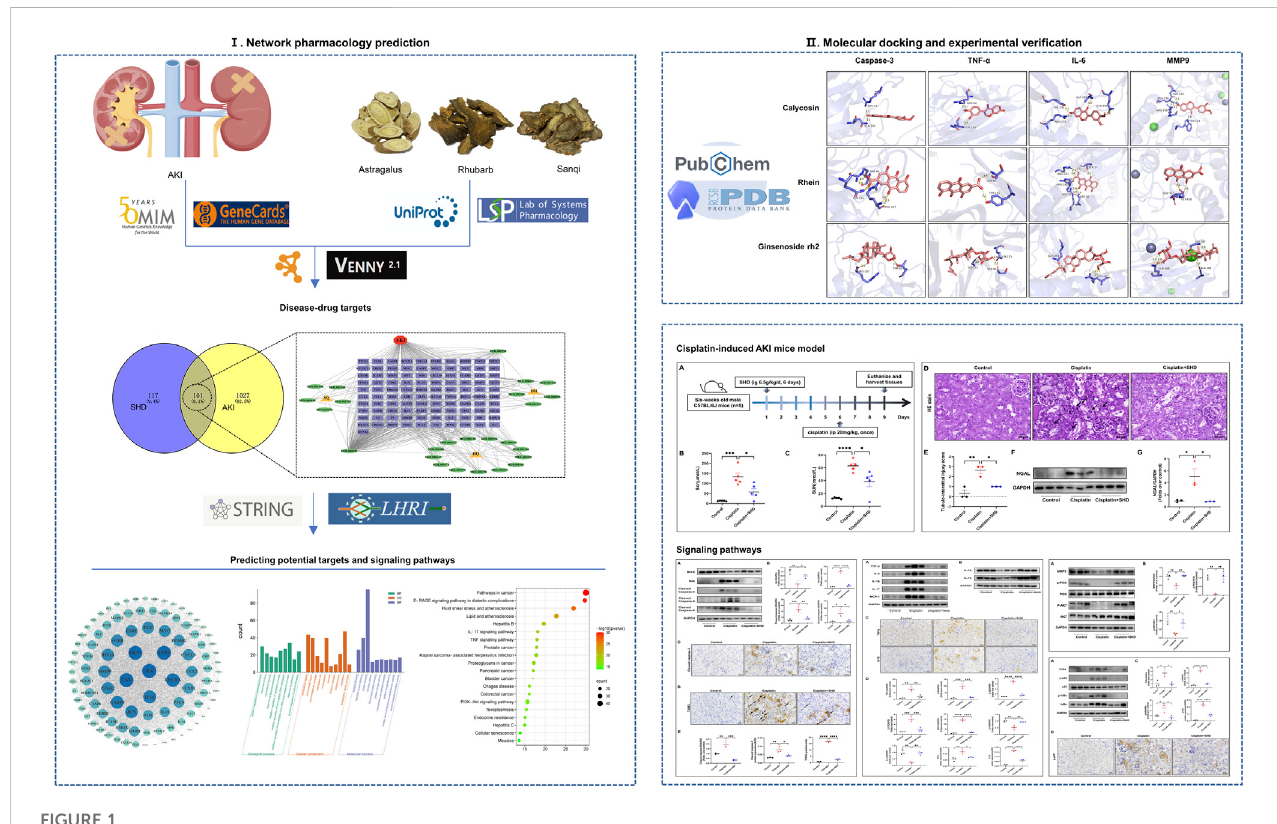
FIGURE 1 Work fl ow chart of the